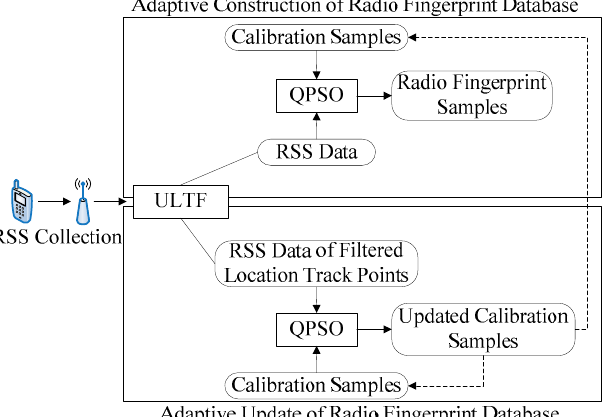
Figure 1. Concept map of adaptive construction and update method based on the quantum-behaved particle swarm optimization–user-location trajectory (QPSO–ULTF) algorithm.